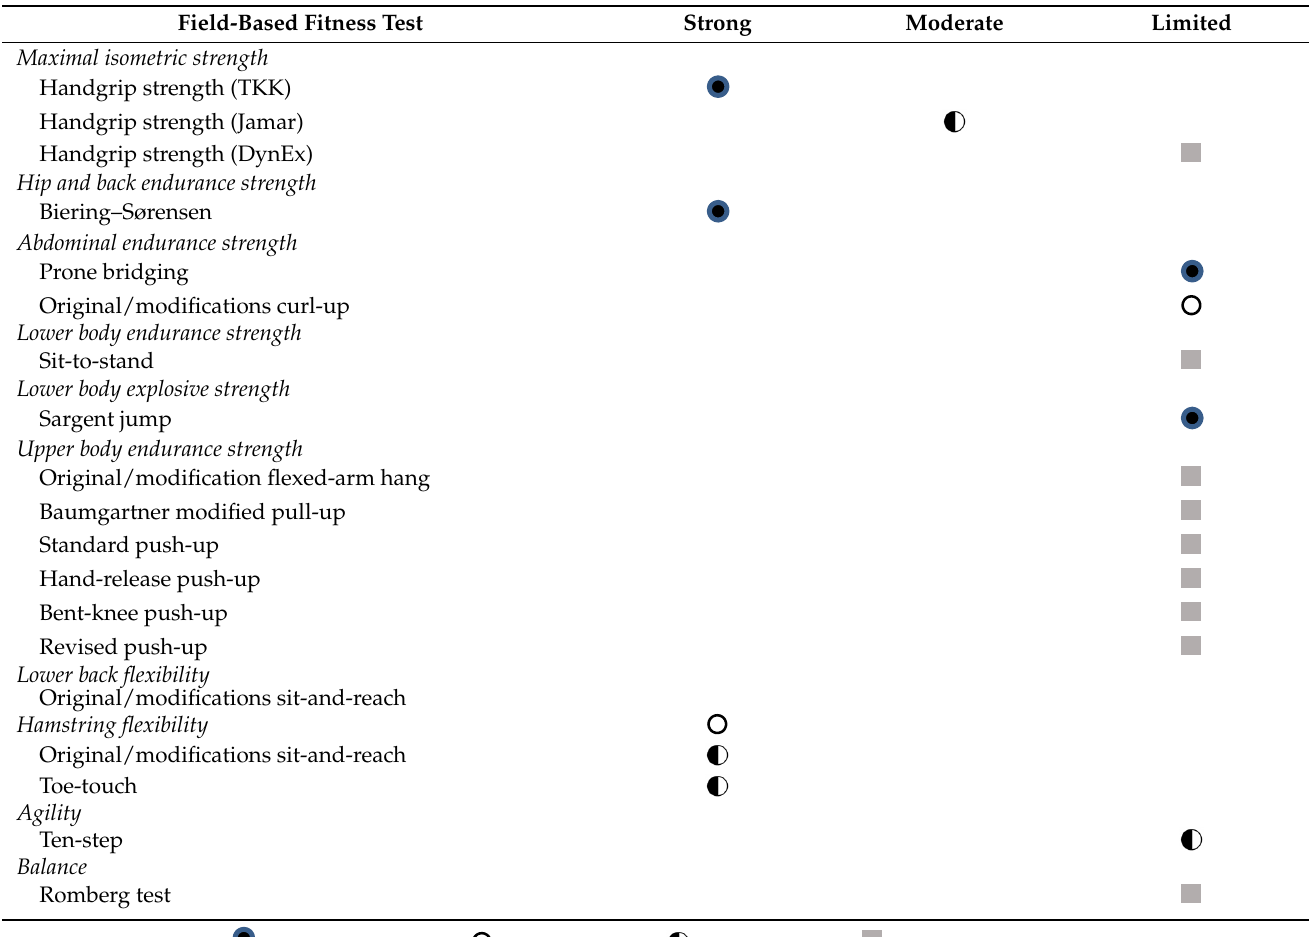
Table 2. Levels of evidence of muscular strength, flexibility and motor fitness tests. Table 1. Levels of evidence of cardiorespiratory fitness tests.